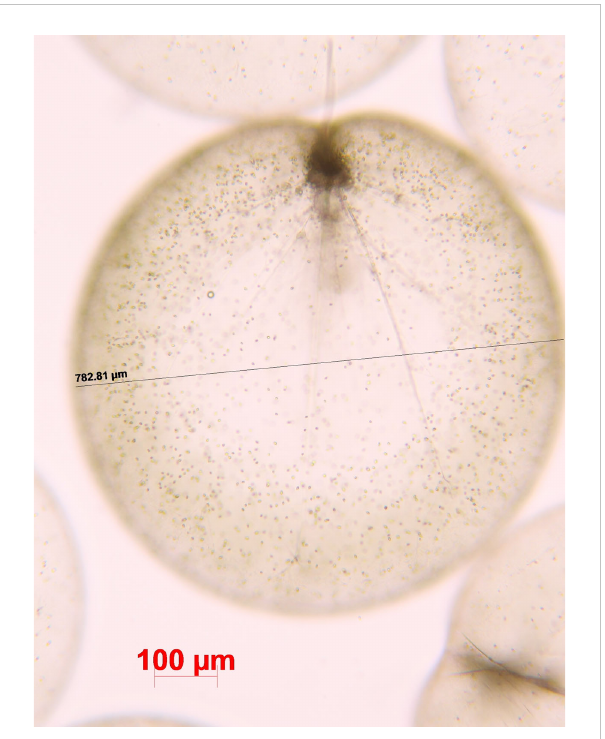
FIGURE 1 A cell of green Noctiluca scintillans. Photo by Dr. Vichaya